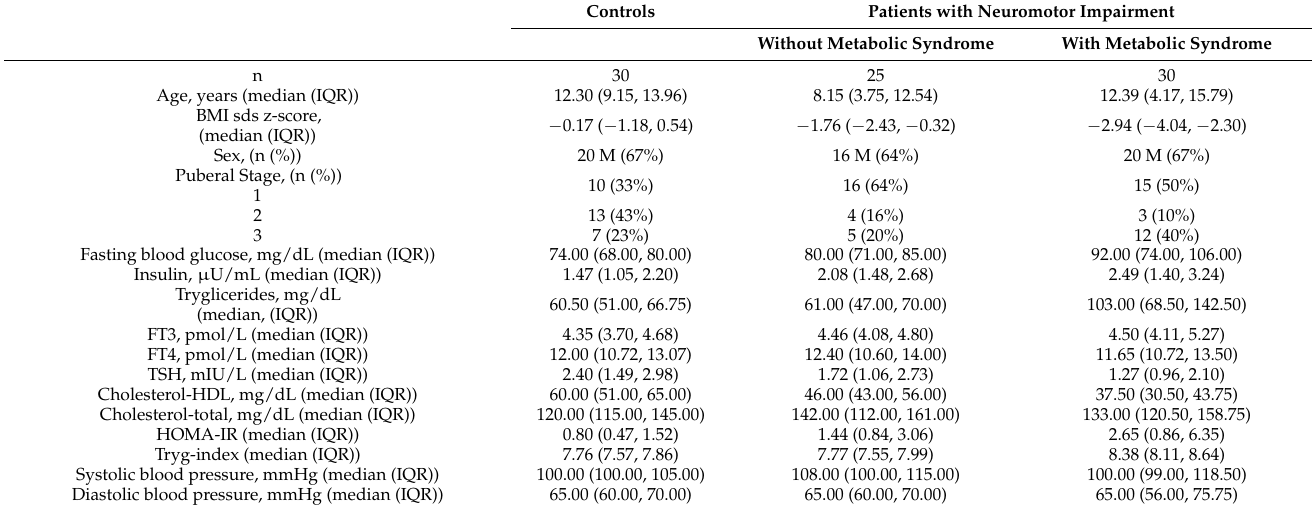
Table 1. Metabolic parameters, thyroid hormones in patients with neuromotor impairment and controls.